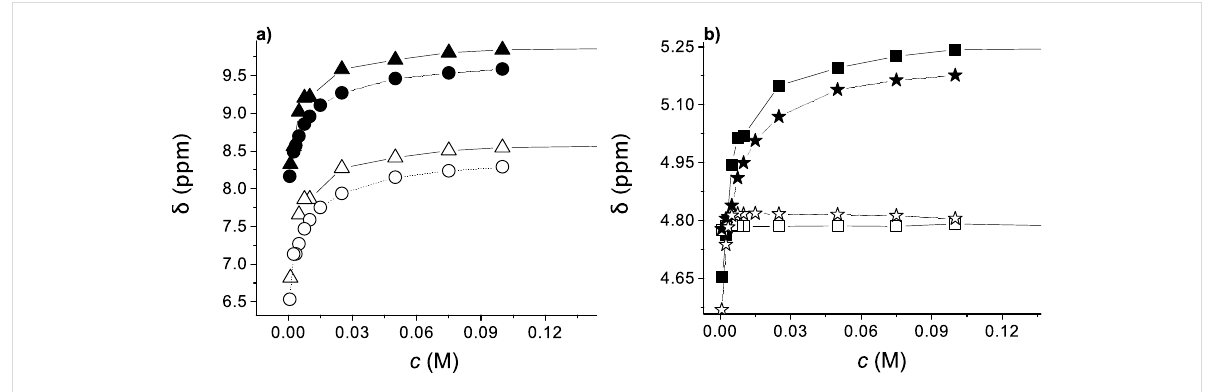
Figure 6: The concentration dependence of NH and C*H chemical shifts in ( S,S )- 1b and its racemate ( S,S )- 1b /( R,R )- 1b toluene- d 8 gels (concentra- tion range 0.001–0.1 mol dm − 3 ): a) ( S,S )- 1b oxalamide-NH protons ( ▲ ) and Leu-NH protons ( Δ ); the racemate oxalamide-NH protons ( ● ) and Leu- NH protons (O); b) ( S,S )- 1b oxalamide- α -Leu-C*H ( ■ );( S,S )- 1b oxalamide- β -Leu-C*H ( □ ); the racemate oxalamide- α -Leu-C*H ( ); racemate oxalamide- β -Leu-C*H (